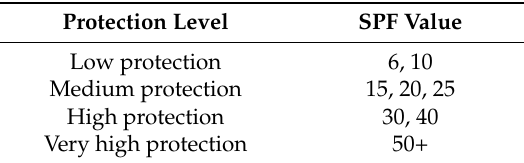
Table 1. SPF classification table.